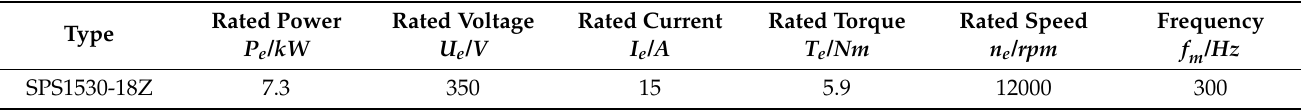
Table 10. Technical parameters of the sample motorized spindle.